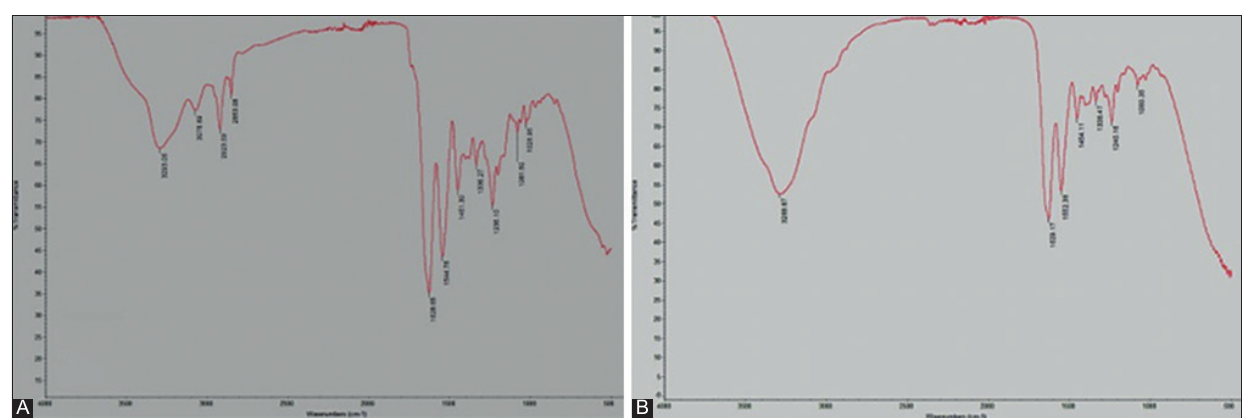
Figure-1: Fourier Transform Infrared Spectroscopy result; A. Collagen Fleece; B. Collagen extract derived from Gouramy fish Table-1: Composition of collagen fleece ® with collagen extracted from gouramy fish scales. Collagen fleece ® Collagen extracted from gouramy fish scales